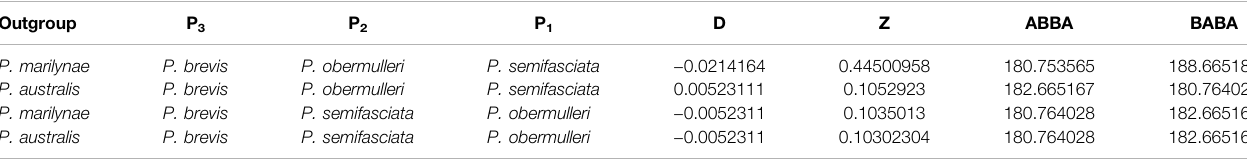
Abbreviations:D,overrepresentationofABBAagainstBABApatternsasmeasuredbytheD-statistics;Z,Z-scoretesttoassesswhethertheD-statisticsissigni fi cantly(Z > 3)differentfrom zero; ABBA, frequency of ABBA patterns; BABA, Frequency of BABA